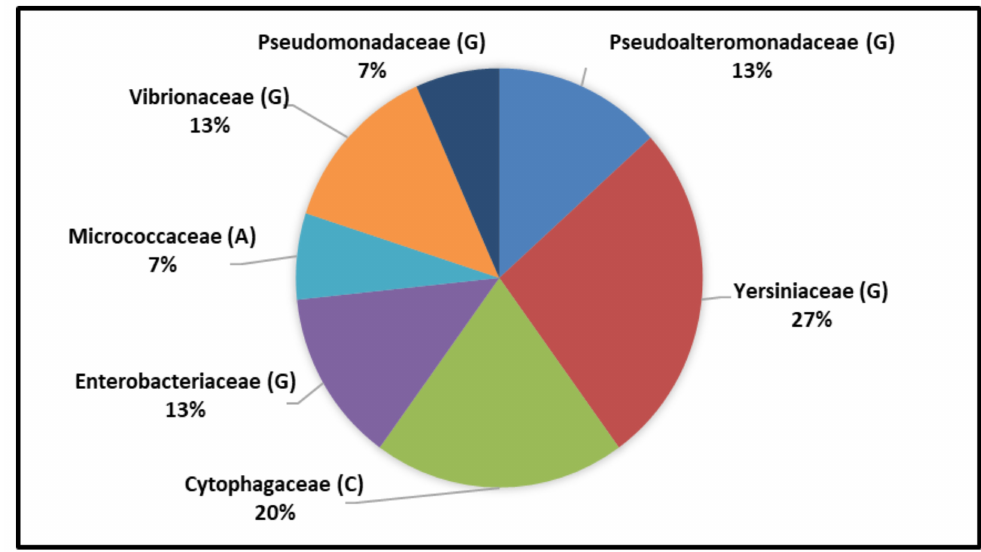
Figure 4. Proportion of coral ( P. damicornis ) mucus bacterial isolates based on the biochemical approach (A: Actinomycetia; C: Cytophagia; and G: Gammaproteobacteria).